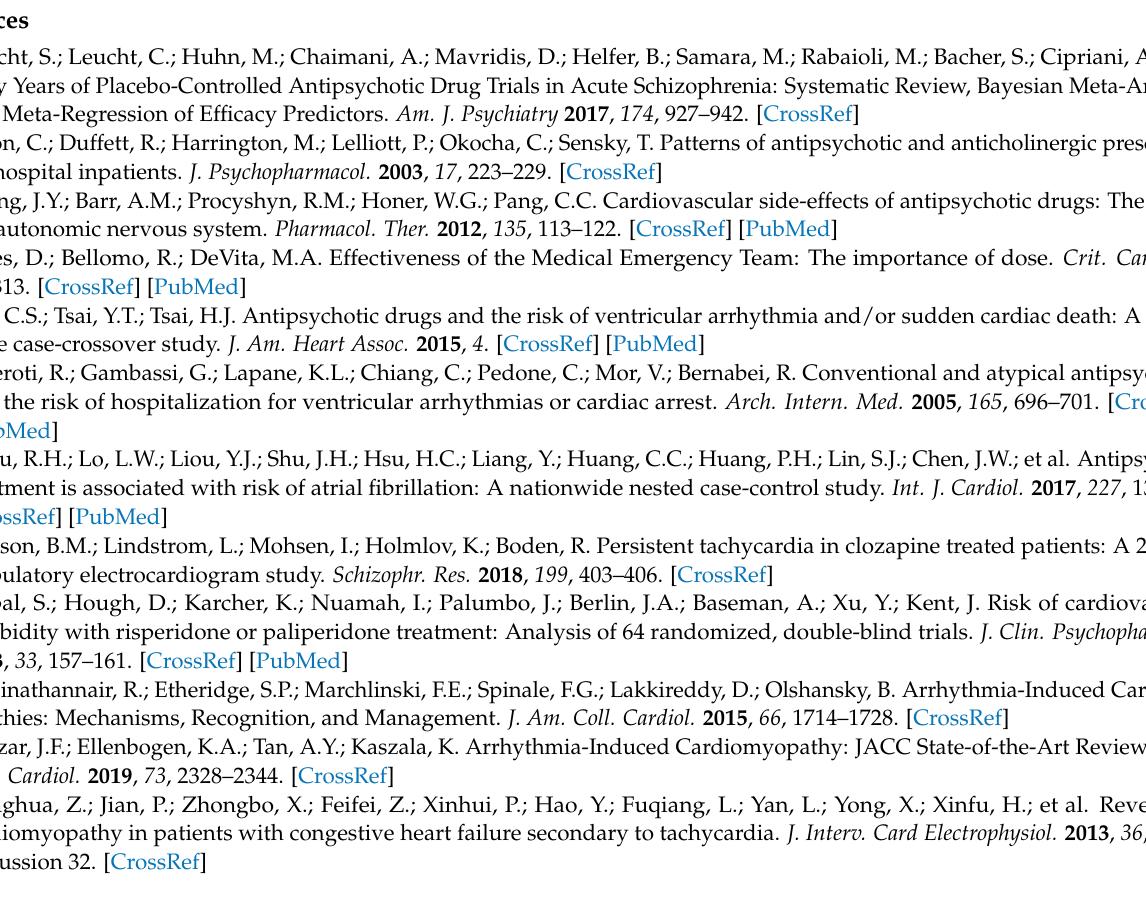
Figure S3: Multivariable model diagnostic testing and